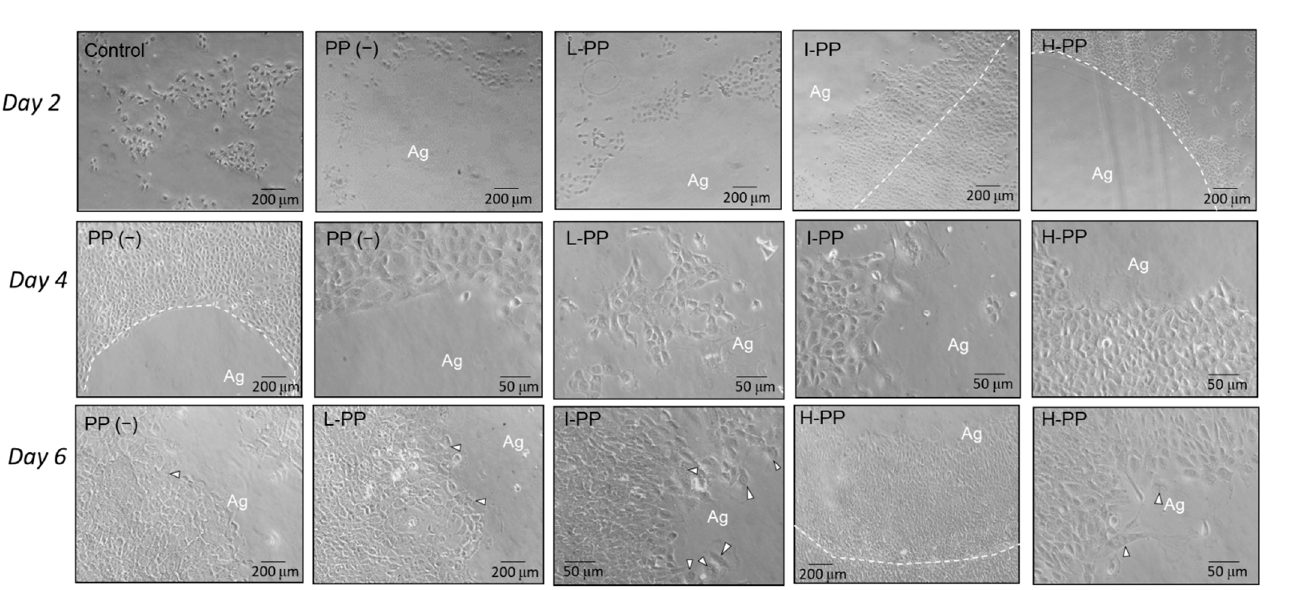
Figure 2. Histology of cell proliferation on Days 2, 4, and 6. On Day 2, cells in the control group scattered, while cells in the other groups colonized around the bead. Only cells in group I-PP intruded across the border of the agarose bead (indicated by the dash line). On Day 4, cells in PP( − ) were still surround the agarose bead. L-PP, I-PP, and H-PP showed cells intruding into the beads. On Day 6, all groups show large squamoid cells intruding into agarose gel containing many granules. The activity of cell division is high (indicated by hollow arrowheads). Magnification at 40× or 200×.